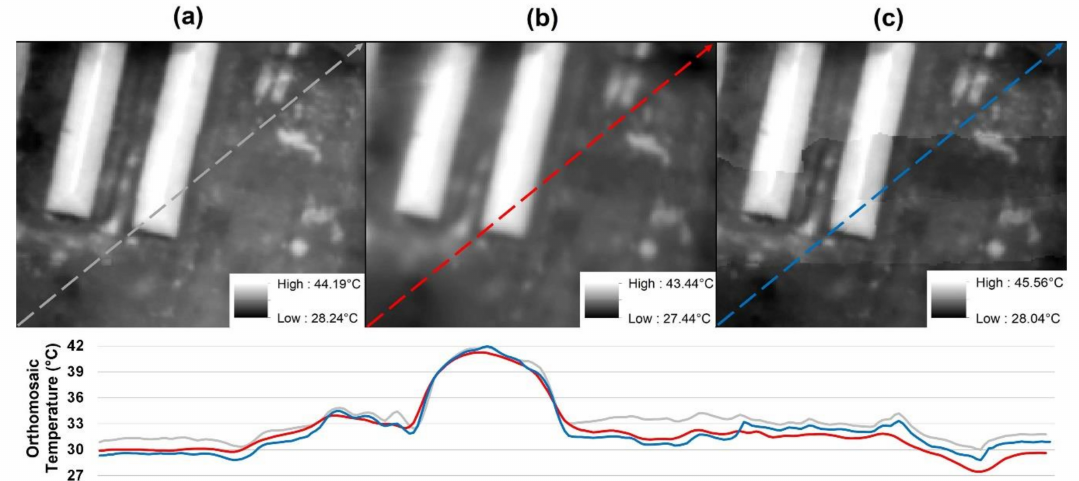
Figure 7. Zoomed view of the area based on orthomosaics from mission E with mosaic ( a ) and averaged ( b ) blending modes, and with blending disabled ( c ). The profile graph illustrates temperature values along the transect from orthomosaics using the blending modes